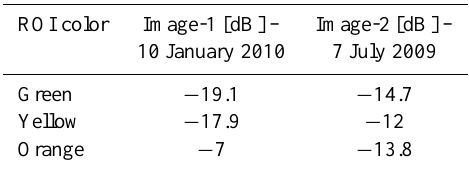
Table 2. Mean values of the radar return in the ROIS drawn on Fig. 3. ROI